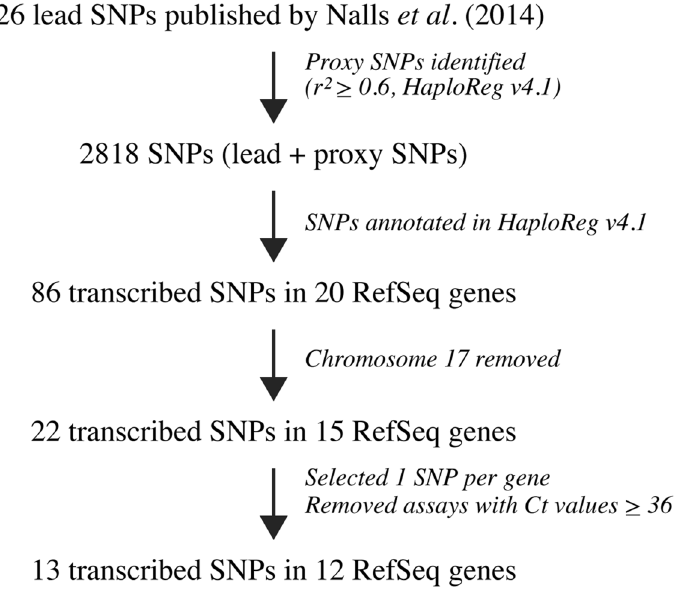
Figure 1. Study design and systematic identification of transcribed single nucleotide polymorphisms (SNPs) suitable for allelic expression analysis of Parkinson’s disease (PD) risk loci. PD genome-wide associated risk SNPs were taken from Nalls et al. 5 and proxy SNPs were identified in the HaploReg database v4.1. Adapted from Locke et al. 19 . Ct cycle